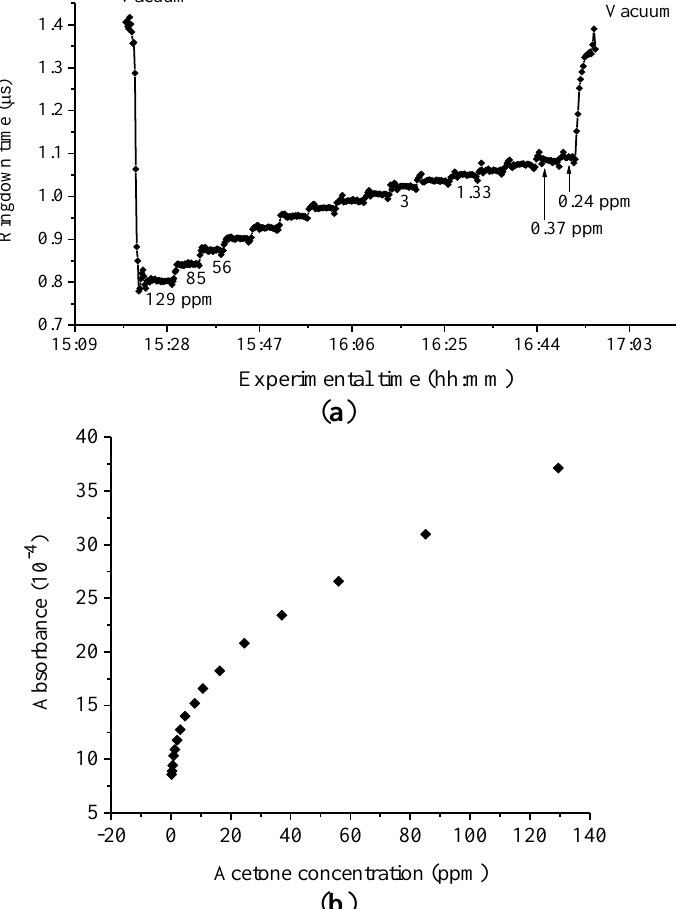
Figure 6. ( a ) Ringdown absorption graph for acetone at 266 nm ( b ) Corresponding curve of the absorbance versus